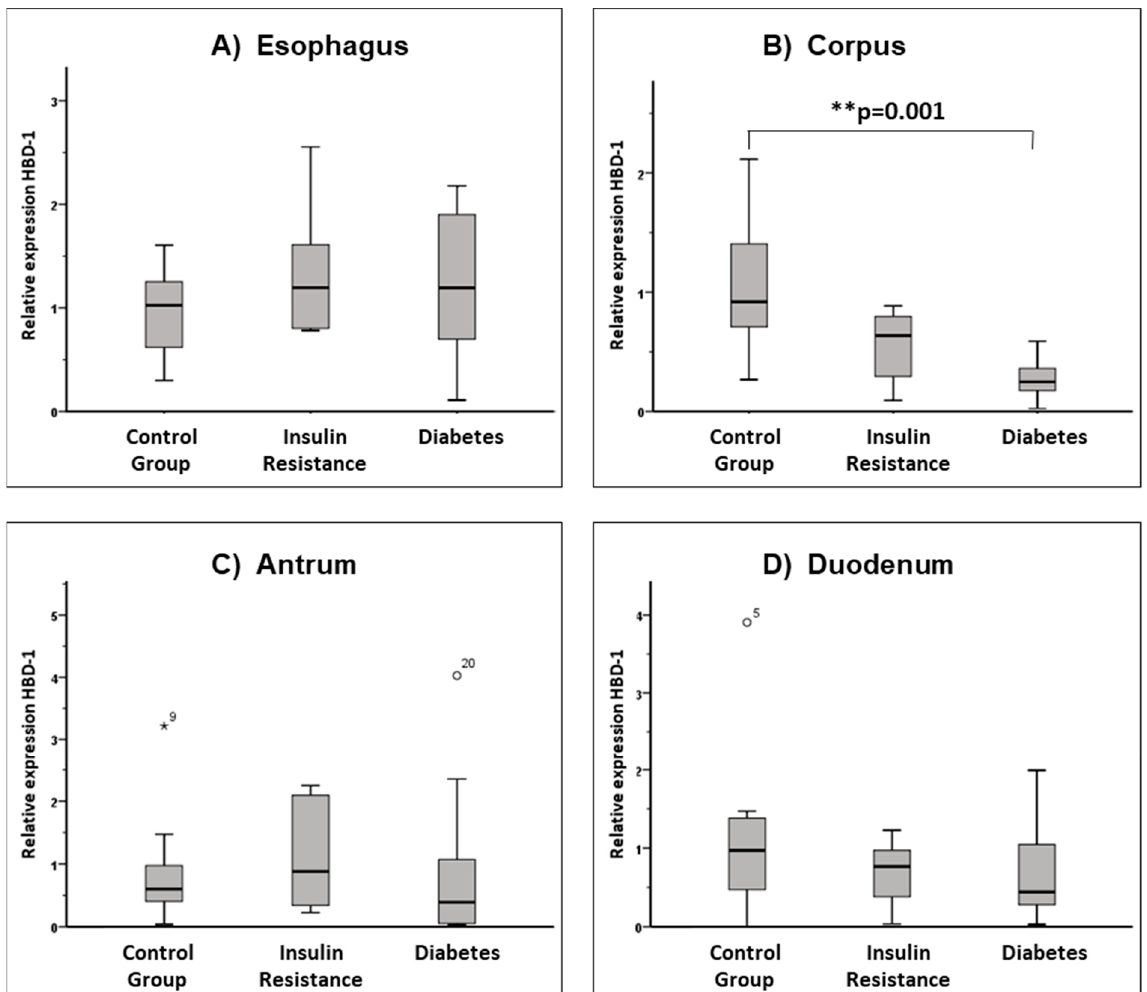
Figure 1. Relative expression of HBD1 in the upper gastrointestinal tract. Box whisker plots presenting relative mRNA expression of HBD1 in the mucosal biopsies of the three groups studied: control group (n = 11), insulin resistance (n = 10) and diabetes group (n = 10) in the locations ( A ) esophagus, ( B ) corpus, ( C ) antrum, and ( D ) duodenum. In the control group, HBD1 mRNA could be detected in the esophagus in 10 patients, and in the gastral corpus, antrum and duodenum in 11 patients. In the insulin resistance group and the diabetes group, HBD1 mRNA was detected in all patients in all samples studied. There is a significant ( p = 0.001) difference in expression in the corpus between the controls and patients with diabetes. Far outliers have been marked with a star 9 , outliers with a circle: 20 , 5 . The superscripted number indicates which observation in the data set is the outlier .